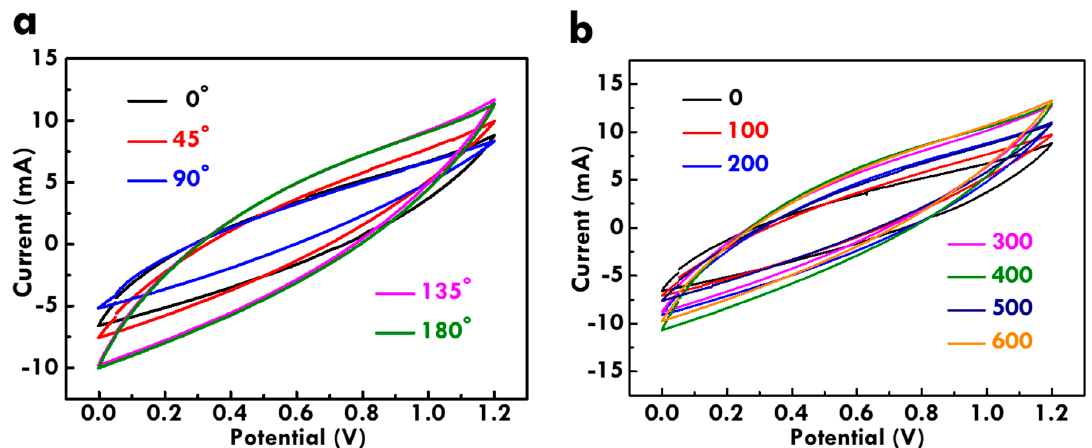
Figure 7. CV curves at 10 mV / s for FSC with varied ( a ) bending angles and ( b ) times at 180 ◦ .